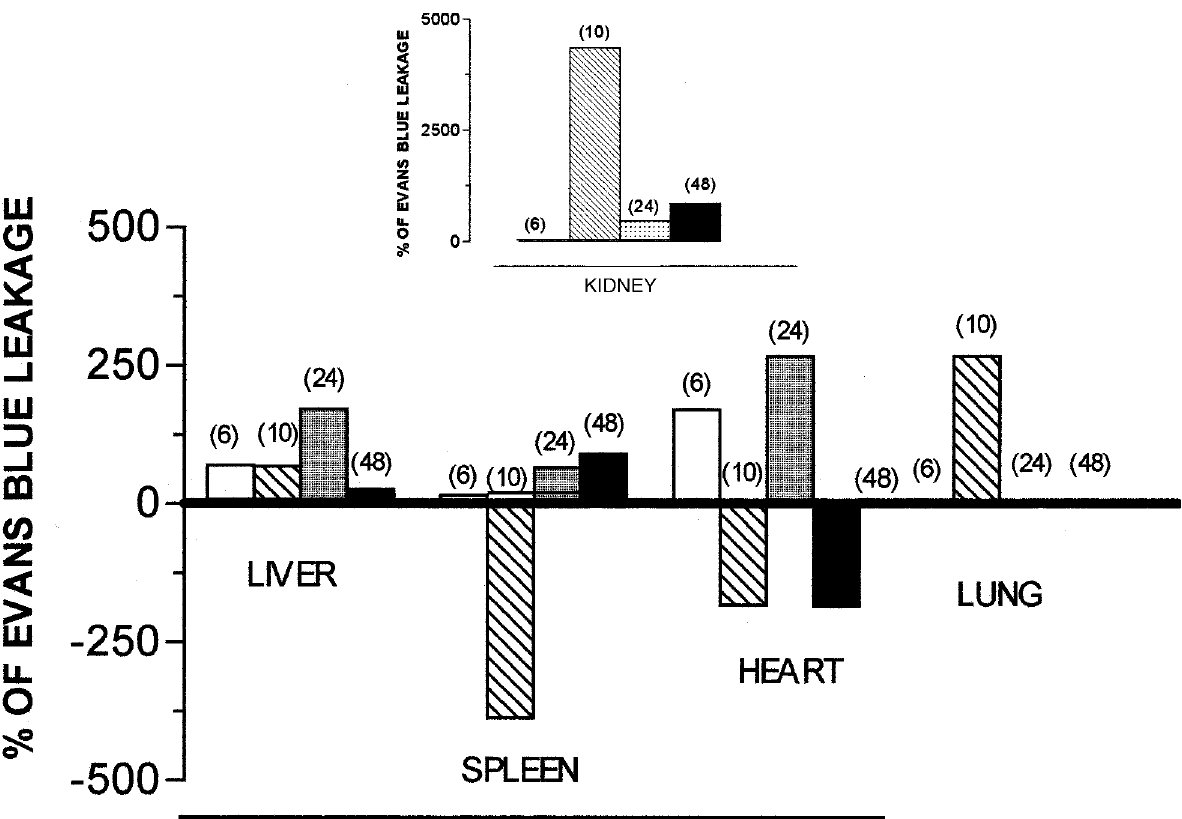
FIG. 3. Time-course profile of fluid leakage in several organs after peritonitis induction. Values are expressed as a percentage in comparison with controls (sham-operated groups). Inset: Same changes in the kidney. Numbers in parentheses indicate the time (h) of evaluation after peritonitis induction. Each column represents the mean values of a pool of four to six animals.